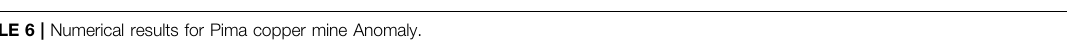
TABLE 6 | Numerical results for Pima copper mine Anomaly. Model parameters Selected ranges Result Error